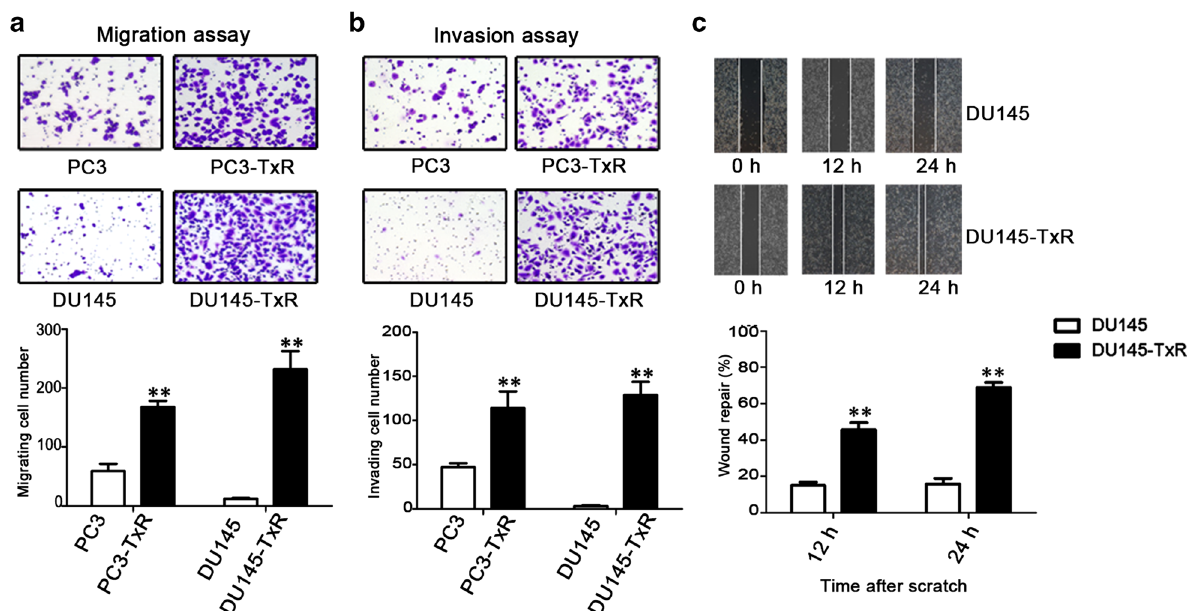
Fig. 2 Chemoresistant PCa cells show enhanced migration and invasion abilities in vitro. a Migratory abilities of PC3, DU145, PC3-TxR, and DU145- TxR cells were determined using transwell assay. b Invasive abilities were determined using transwell assay. On each filter, five microscopic fields (at 200 magnification) were observed, and cells were counted. c Migratory abilities of DU145 and DU145-TxR cells were determined using wound × healing assay. Wounded monolayers of DU145 and DU145-TxR cells were photographed 0, 12, and 24 h after the mechanical scratch, and the widths of the wounds were measured in 3-independent wound sites per group. Wound repair was calculated. The mean independent experiments are presented. * P < 0.05, ** P <